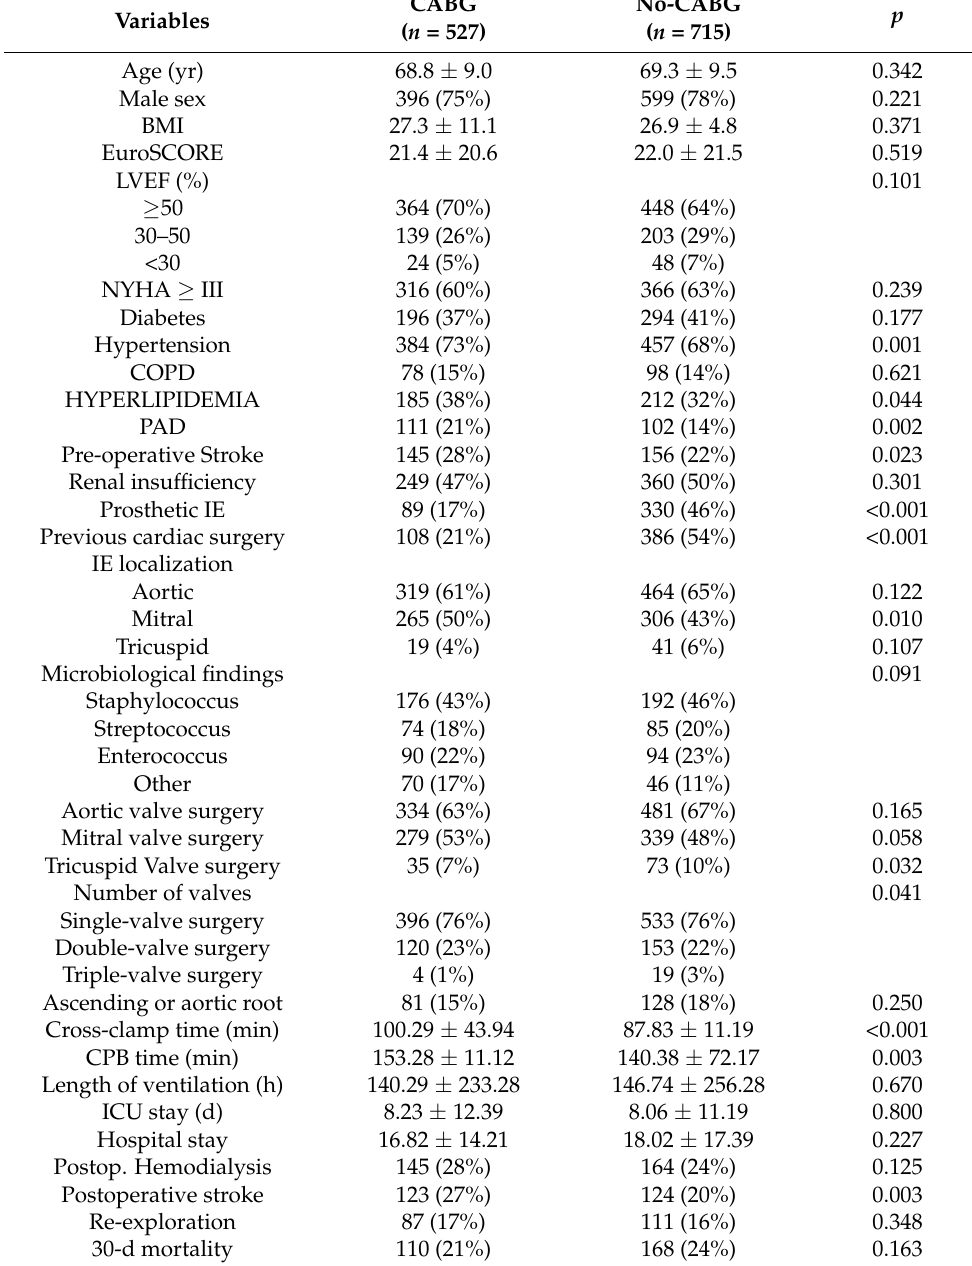
Table 2. Baseline characteristics as well as perioperative data and outcome for patients with CAD divided into patients who received ( n = 527) and those who did not receive concomitant CABG ( n =